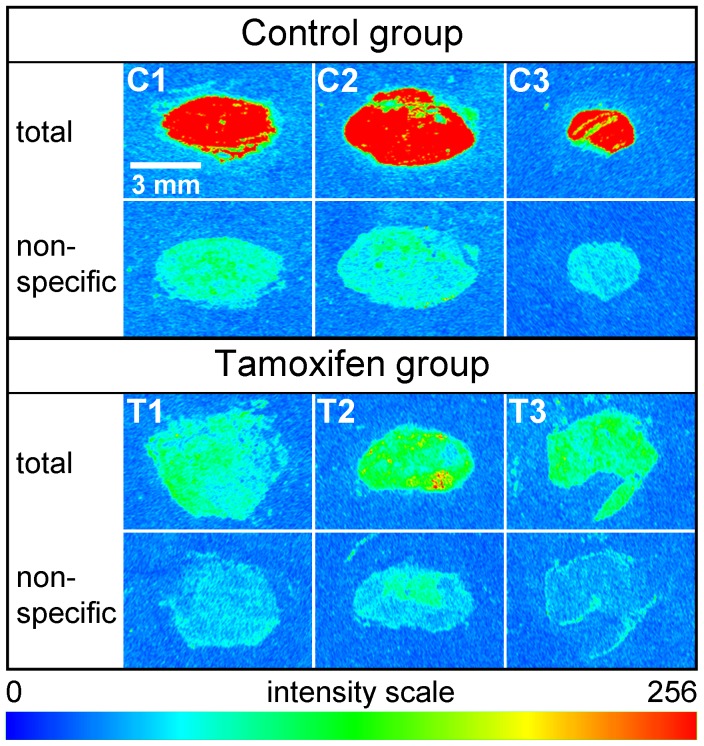
Y1R expression in MCF-7 xenografts is down-regulated by antiestrogens in vivo.Effect of estradiol and tamoxifen on Y1R expression by MCF-7 (L) xenografts in vivo determined by autoradiography using the selective Y1R antagonist [3H]-UR-MK114 (3 nM). Subcutaneously grown tumors from NMRI (nu/nu) mice bearing subcutaneous 17β-estradiol depots. The control group (3 mice, C1–C3) was treated with the vehicle (PEG400/1.8% NaCl, 1∶1). Tamoxifen group (3 mice, T1–T3): A cumulative dose of tamoxifen citrate (36 mg/kg, dissolved in PEG400/1.8% NaCl, 1∶1, at a concentration of 2.4 mg/mL) was administered by injecting three times (on day 2, 6 and 10 after explantation of the estrogen depots) 12 mg/kg subcutaneously.